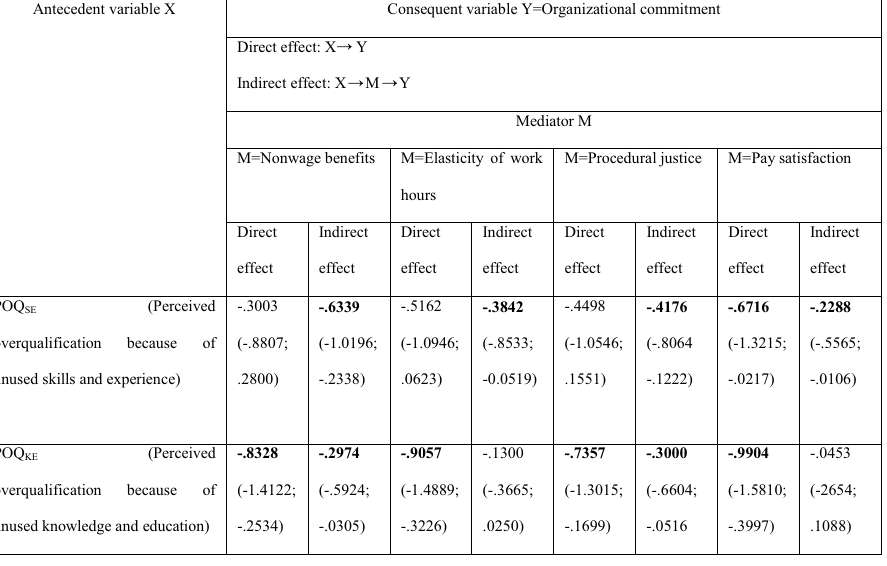
or POQ ) on Organizational commitment as well as indirect effects by one of four SE KE